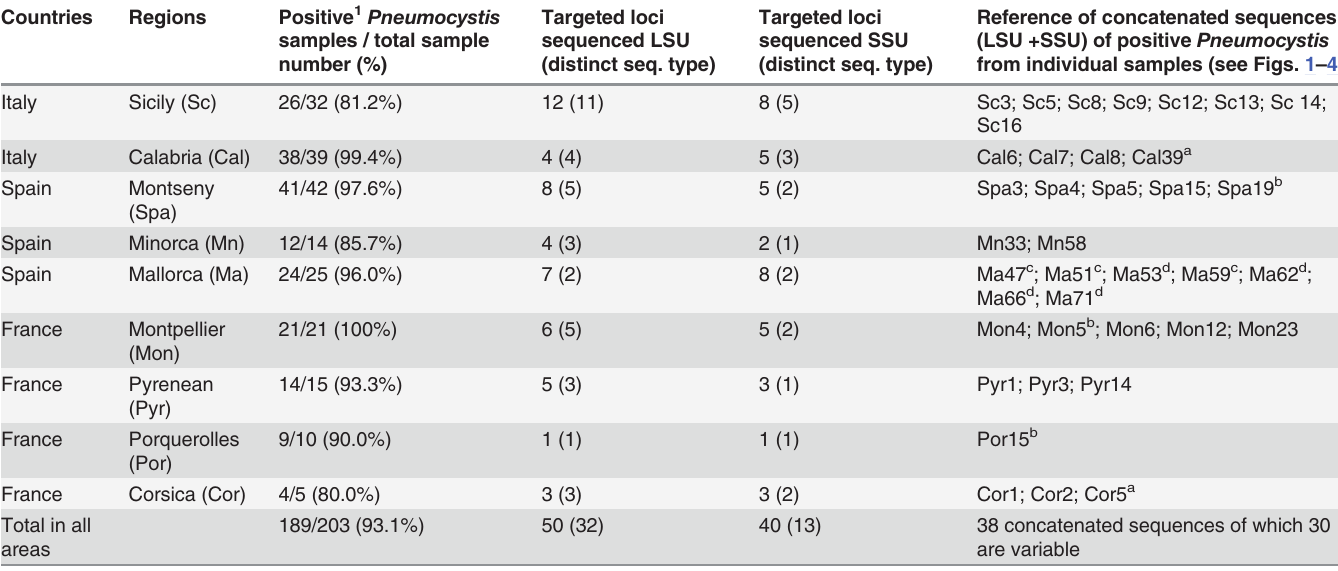
Table 1. Prevalence of Pneumocystis carriage in woodmice ( Apodemus sylvaticus ) according to rodent geographic origin. Countries